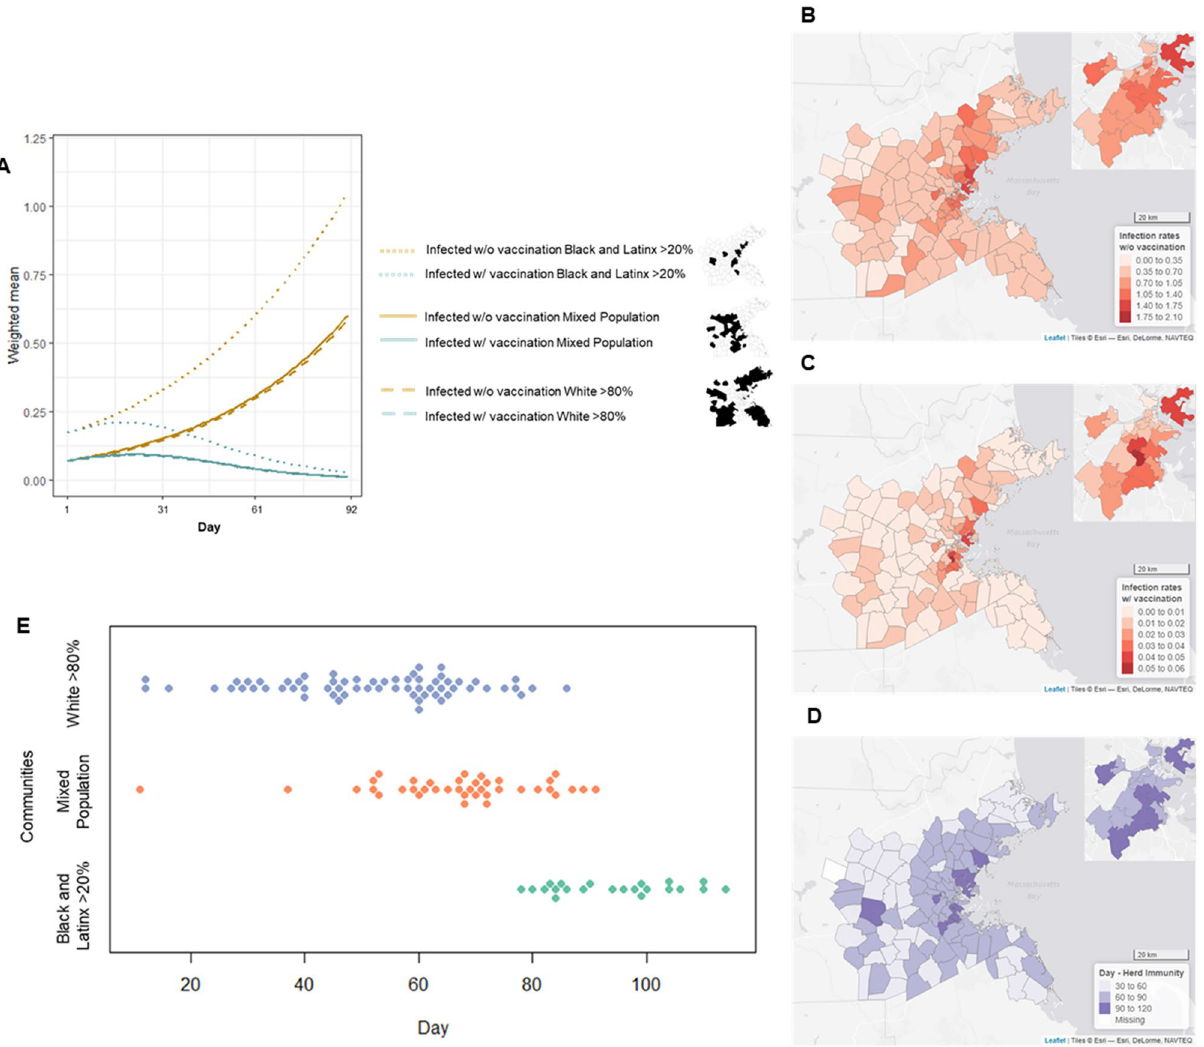
Figure 3. Vaccination rates varied across communities throughout the simulation. ( A ) Growth curves of the percentage of residents intending to vaccinate, will maybe vaccinate, and have been vaccinated across the 3-month simulation, broken out by communities that are predominantly White, high Black–Latinx, and other. These different curves resulted in disparities across communities in ( B ) the total percentage of those vaccinated at the end of the simulation, ( C ) infection rates at the end of the modeling process, ( D ) and the day when herd immunity was reached, while ( E ) shows a graphic representation of when communities reached herd immunity. (Made in R Studio V.1.4. http:// www. rstud io. susceptible to infection. Over the following week or so, infection rates started to decrease, eventually nearing zero infections. To wit, 99% of communities had more than one case per 100 without vaccination, whereas no community was above 0.75 cases per 100 with vaccination. The growth curve for infection rates under vaccination was consistent across communities of different racial composition, though with some noteworthy variations. First, the absolute drop in infection rates with vaccina- tion was greater in communities of color, seemingly because they had much higher levels of infection in the no-vaccine scenario. In other words, vaccination held the greatest absolute benefit for communities harder hit by the virus. The second difference, however, was how close they came to herd immunity. Predominantly White communities nearly reached zero infections (3rd quartile = 0.10 cases per 100 residents). Meanwhile, communi- ties with high Black–Latinx populations failed to reach this point, averaging 0.27 infections per 100 residents at the end of the simulation (Fig. 3A–C). A series of linear regression models confirmed the racial disparities in infection rates under the vaccination scenario (see Table 1 for all parameters). Communities with greater Black and Latinx populations had higher infection rates at the conclusion of the simulation (% Black: B = 0.30, p < .001; % Latinx: B = 0.54, p < .001). Even when we controlled for expected infection rates, as drawn from the no-vaccine scenario, these racial disparities persist, meaning that differential uptake of the vaccine played a consequential role in cross-community variations in infection (% Black: B = 0.26, p < .001; % Latinx: B = 0.26, p < .001).